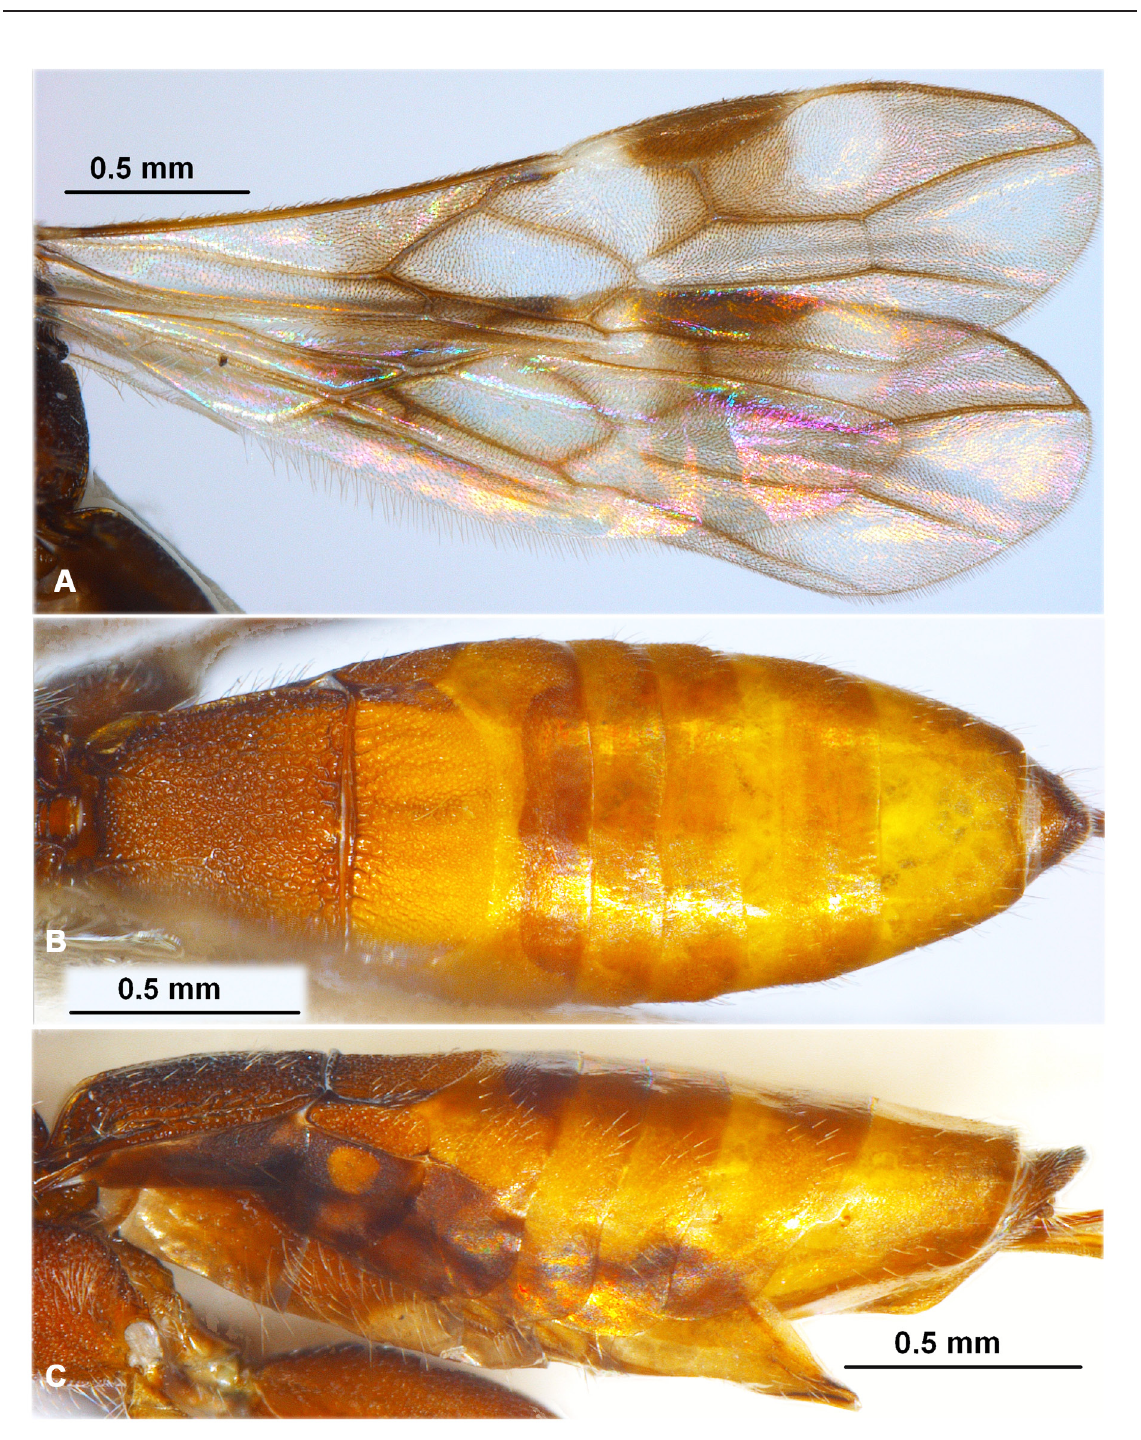
Fig. 37. Hemidoryctes carbonarius postfurcalis Belokobylskij subsp. nov., holotype, ♀ (RMNH). A . Wings. B . Metasoma, dorsal view. C . Metasoma, lateral